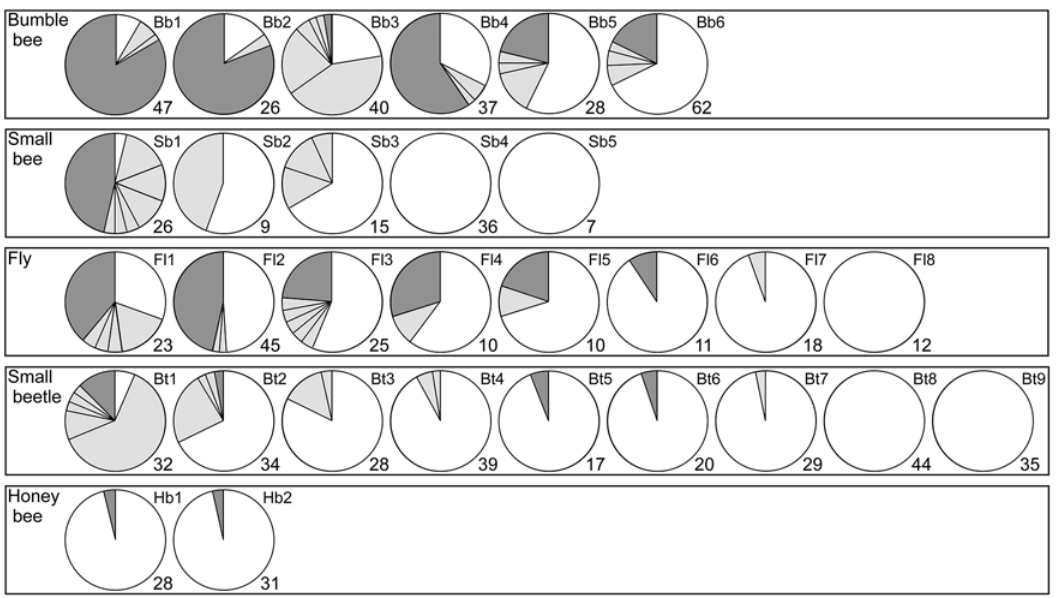
Fig 1. Pollen-donor compositions found on insects visiting Castanea crenata . Each pie chart represents an individual insect. White segments represent self-pollen, light segments individual pollen donors from within the plot, and dark segments pollen donors from outside the plot. Numbers of pollen grains tested for paternity are indicated. IDs for individual insects correspond to Table